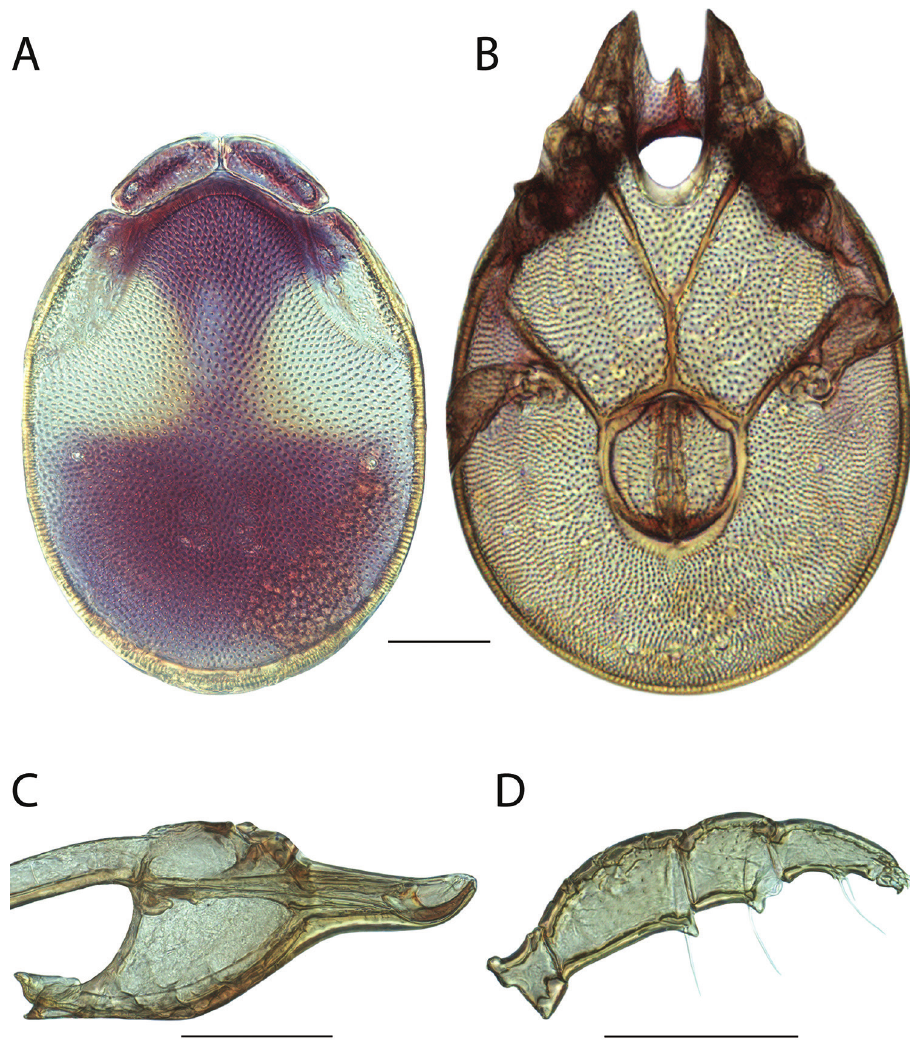
Figure 277. Torrenticola whitneyae sp. n. male: A dorsal plates B venter (legs removed) C subcapitulum D pedipalp (setae not accurately depicted). Scale = 100